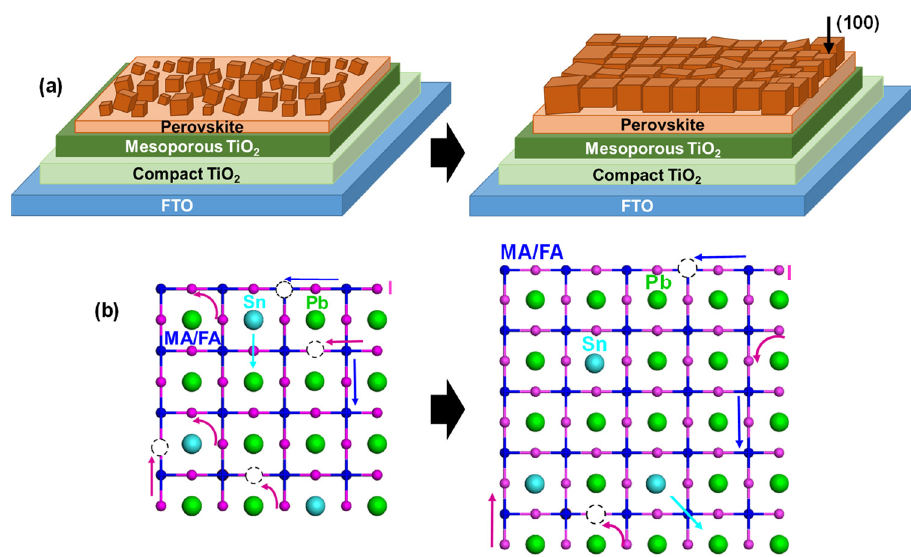
Figure 7. Schematic illustration of ( a ) crystal growth and ( b ) the ionic diffusion in perovskite crystals. Growth rates of perovskite grains for the devices were compared. The initial grain size of the crystal is d 0 (m), the material/temperature-dependent constant is K (m 2 s − 1 ), the constant is n , and the temperature retention time is t r (s). The crystal grain size was d (m), and the constant K was calculated using the following formula d n − d n Table 6. The n changes depending on the variable, and the n was set as 2 because of a single perovskite layer. d and d 0 values were determined from the particle sizes. The K values for the standard and Sn/Cu added systems negative and positive,